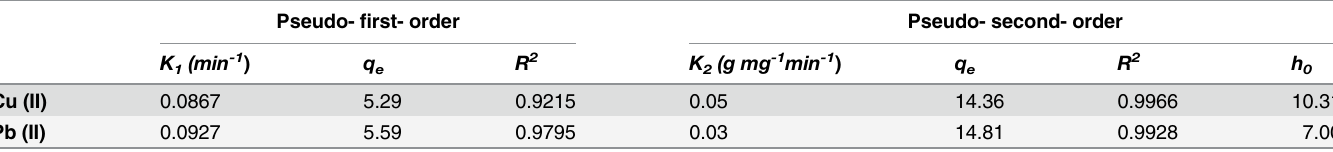
Table 6. Kinetic parameters for the adsorption of Cu(II) and Pb(II) ions by RS/Fe 3 O 4 -NCs. Pseudo- fi rst-